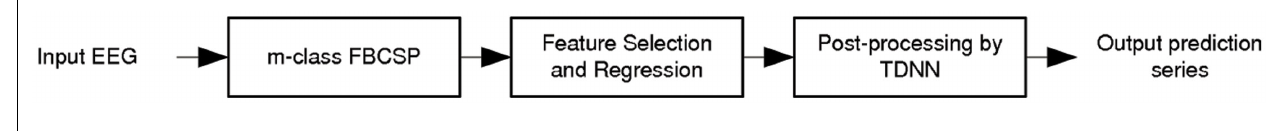
FBCSP stands for filter-bank common spatial pattern (see Section 2), and TDNN for time-delay neural network (see Section